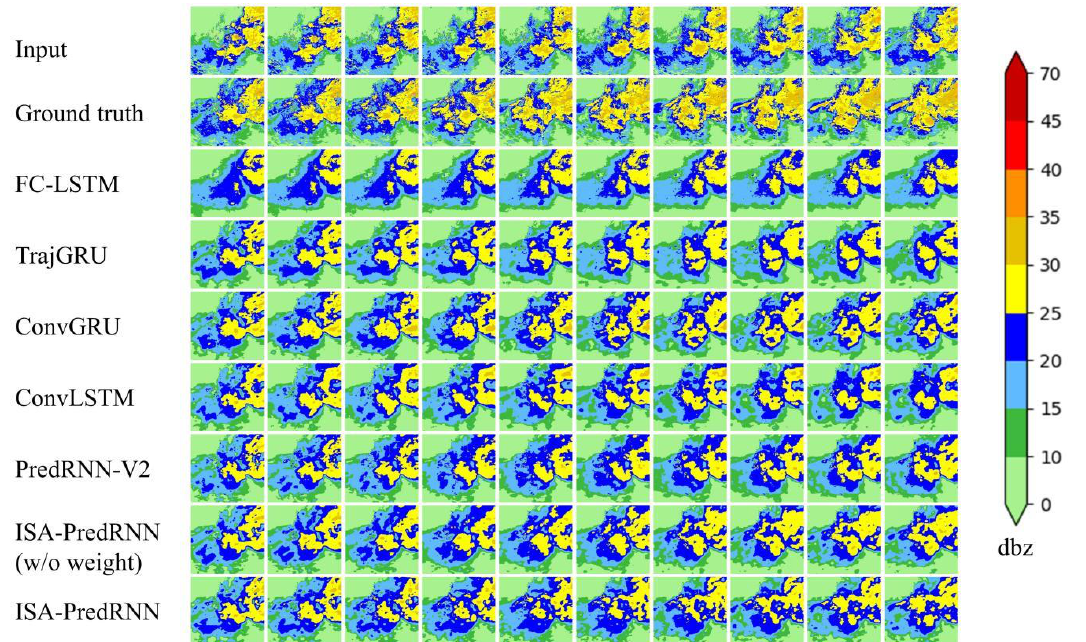
Figure 7. Prediction examples on the radar echo test set, in which the radar echo was strong but changed little. The ten images in the first row represent the radar echo information of the past hour, and the images in the subsequent rows represent the radar echo information of the future hour obtained by different model predictions. The time interval between adjacent images is 6 min.